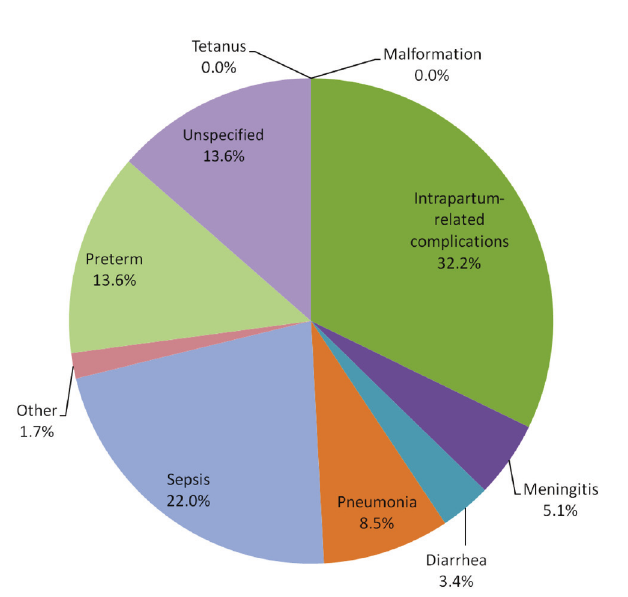
Figure 5. Expert algorithm, hierarchical verbal autopsy causes of death for 59 neonates born and died in the delivery facility, Niger,